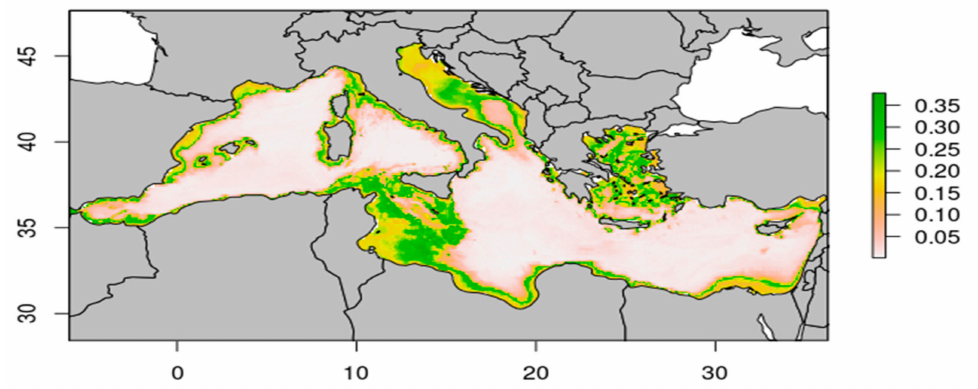
Figure 2. Map of assemblage-level uncertainties in SDM predictions. Uncertainty is calculated at the species level (Equation (1)) and averaged across species present in each planning unit. Green areas indicate cells for which model prediction uncertainties are the